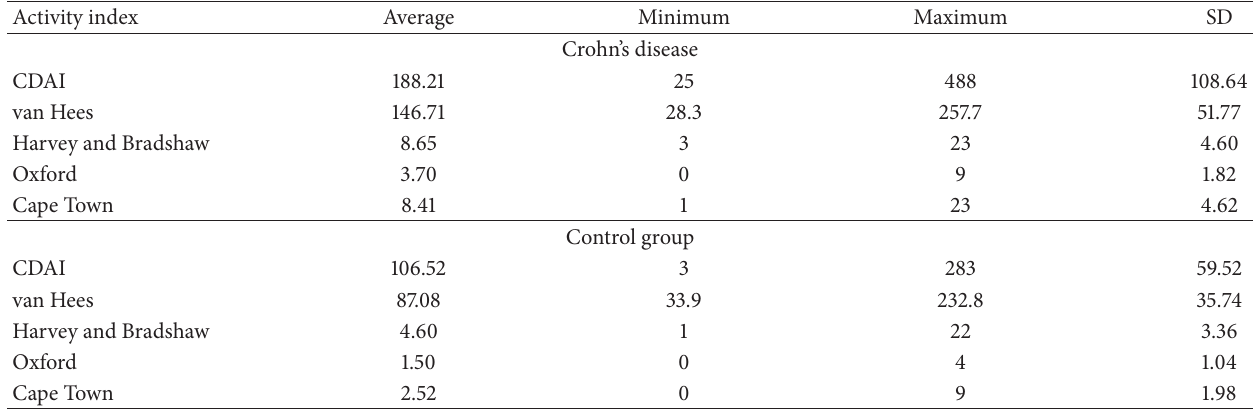
Table 4: Averages as well as minimal and maximal values and standard deviations (SD) for the calculated clinical activity indices in CD patient group and the control